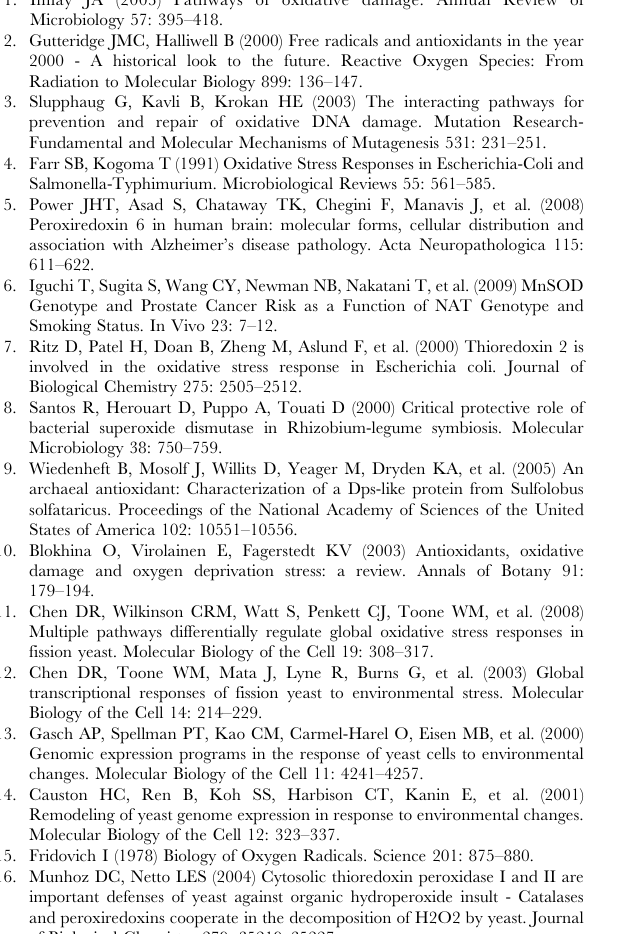
Table S4 Proteins identified within Up-regulated